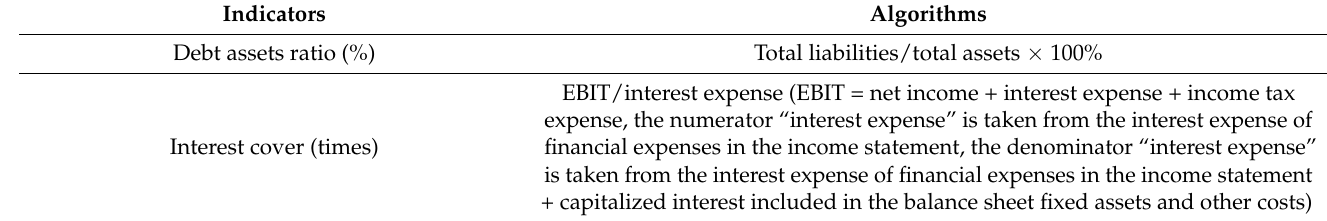
Table 8. Indicators and algorithms of the long-term solvency index.